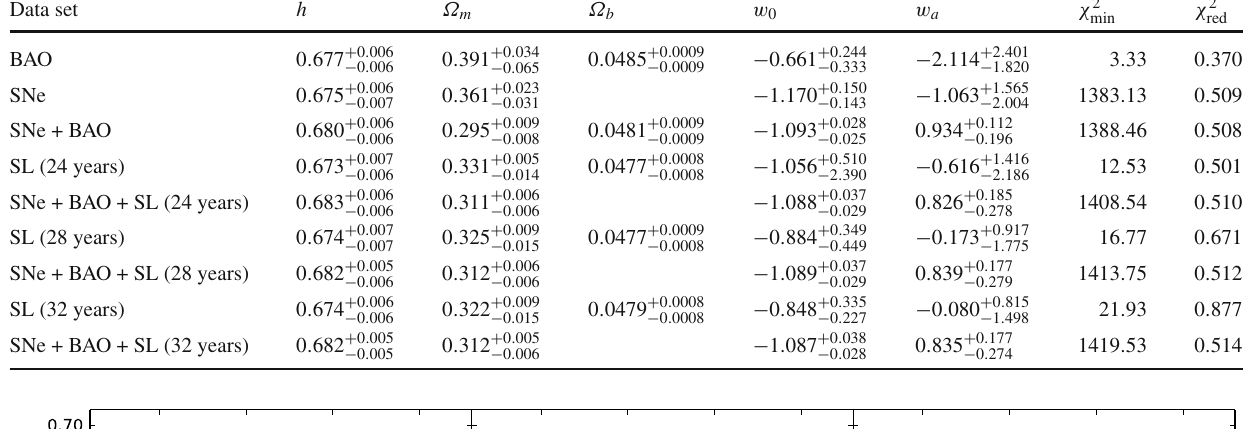
Table 6 Parameter results of the Lazkoz–Sendra pivotal model Data set